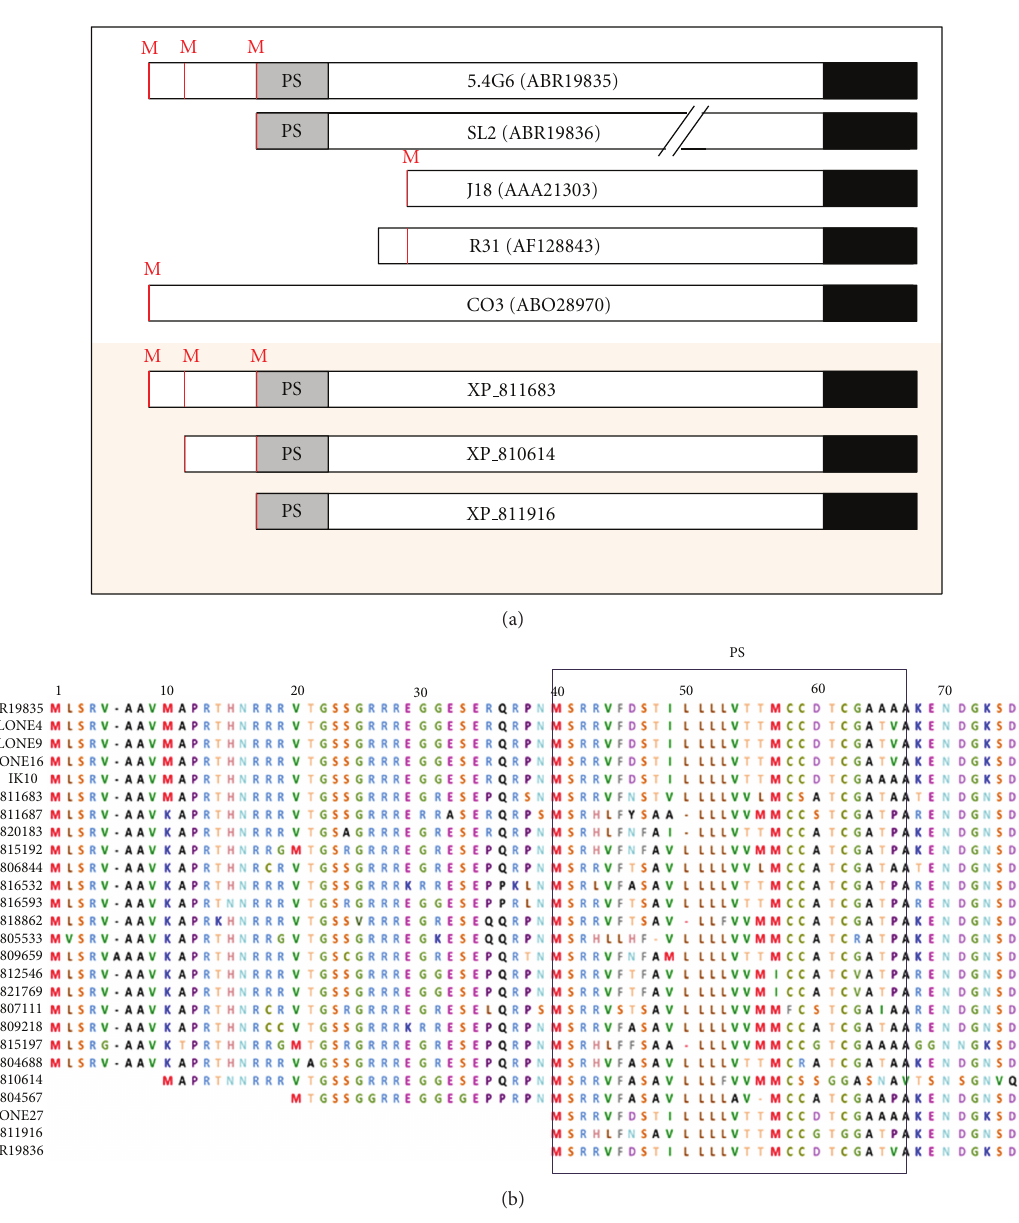
Figure 2: The modular architecture of GP82 family. (a) Structure of GP82 core proteins deduced from cDNA and genomic sequences. Sequences from cDNA clones are listed in the legend of Figure 1. SL (ABR19836) is a truncated cDNA sequence obtained by RT-PCR. The slashes indicate that sequence is interrupted. For ease of viewing, the putative C-terminal was drawn in the same line. GenBank